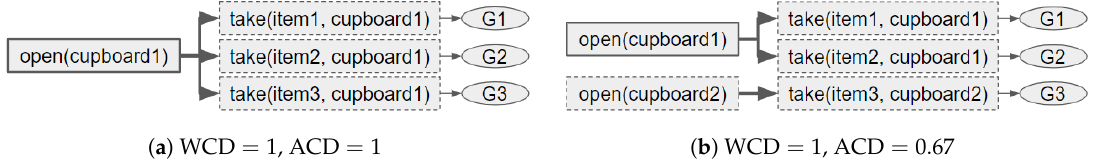
Figure 3. Example plans for 3 goals. The initial actions common to multiple goals (i.e., the non-distinctive prefixes) are indicated by boxes with solid borders. The remaining actions in the plans to the goals are indicated by boxes with dashed